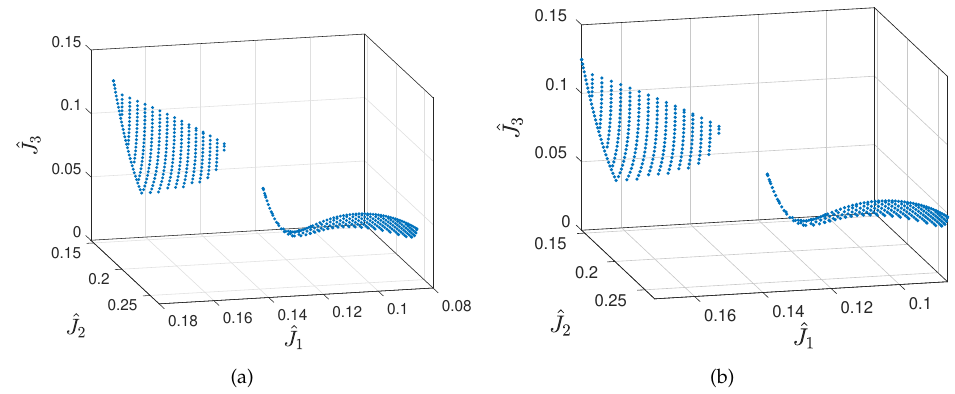
Figure 1. ( a ) Algorithm 2 no Removal local RB spaces. ( b ) Algorithm 2 T3 local RB spaces.